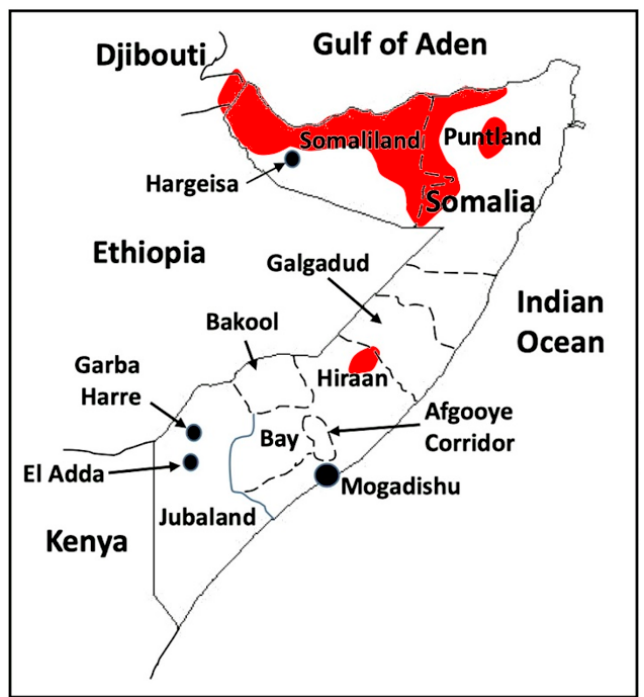
Figure 12. Locations and regions mentioned in the text in relation to desert locust activity and insecurity in Somalia. Primary breeding areas in red.